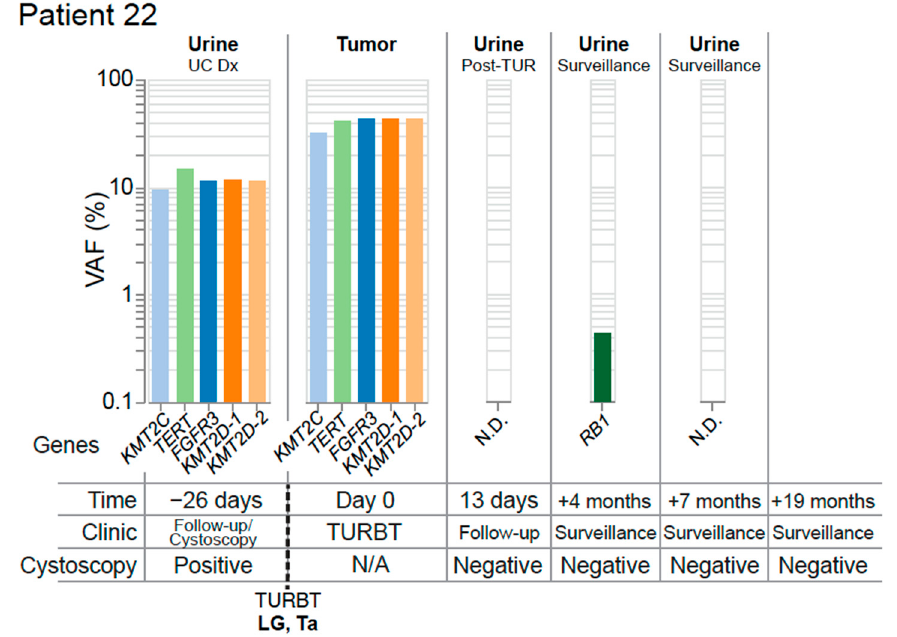
Figure 6. Complete resection with optimal molecular surveillance. The mutation profile of matched tumor and urine samples from Patient 22 are grouped chronologically to demonstrate genomic changes over the course of treatment. Tumor mutations are color-coded to facilitate identifi- cation across longitudinal collections. Multiple mutations are identified in the gene KMT2D, and are distinguished by color and numbered. Abbreviations: none detected (N.D.), diagnosis (Dx).